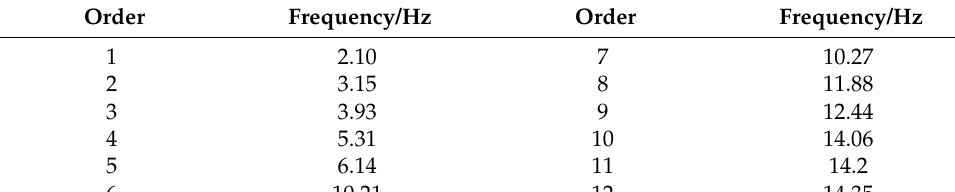
Figure 9. Von Mises stresses diagram of the frame with extreme torsional condition. Table 4. First 12 orders of inherent frequency.